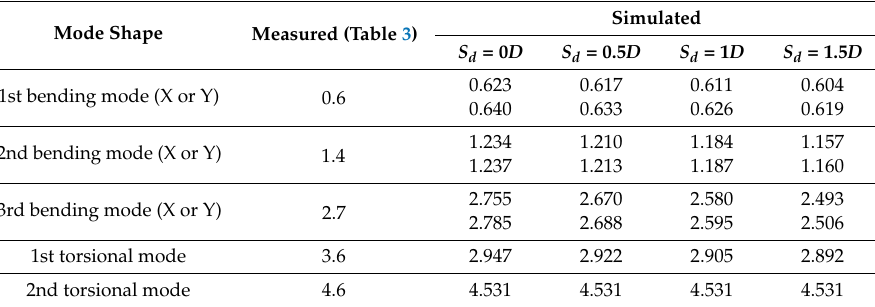
Table 8. Natural frequencies of met mast structure—case 3.